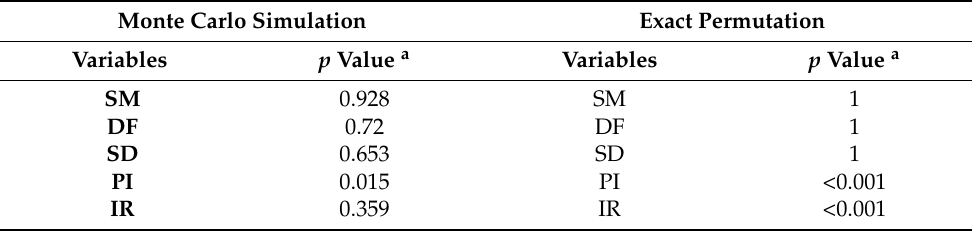
Table 4. Permutation test.